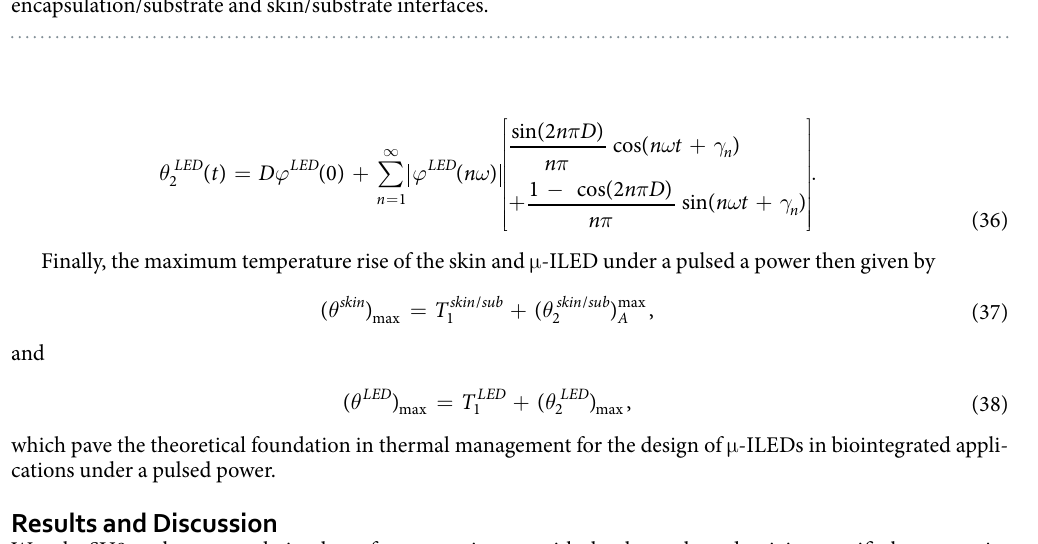
Figure 2. ( a ) The distribution of the steady temperature increase from the core body temperature when μ -ILED is not working. ( b ) The distribution of the temperature increase due to the applied power of 10 mW at the encapsulation/substrate and skin/substrate